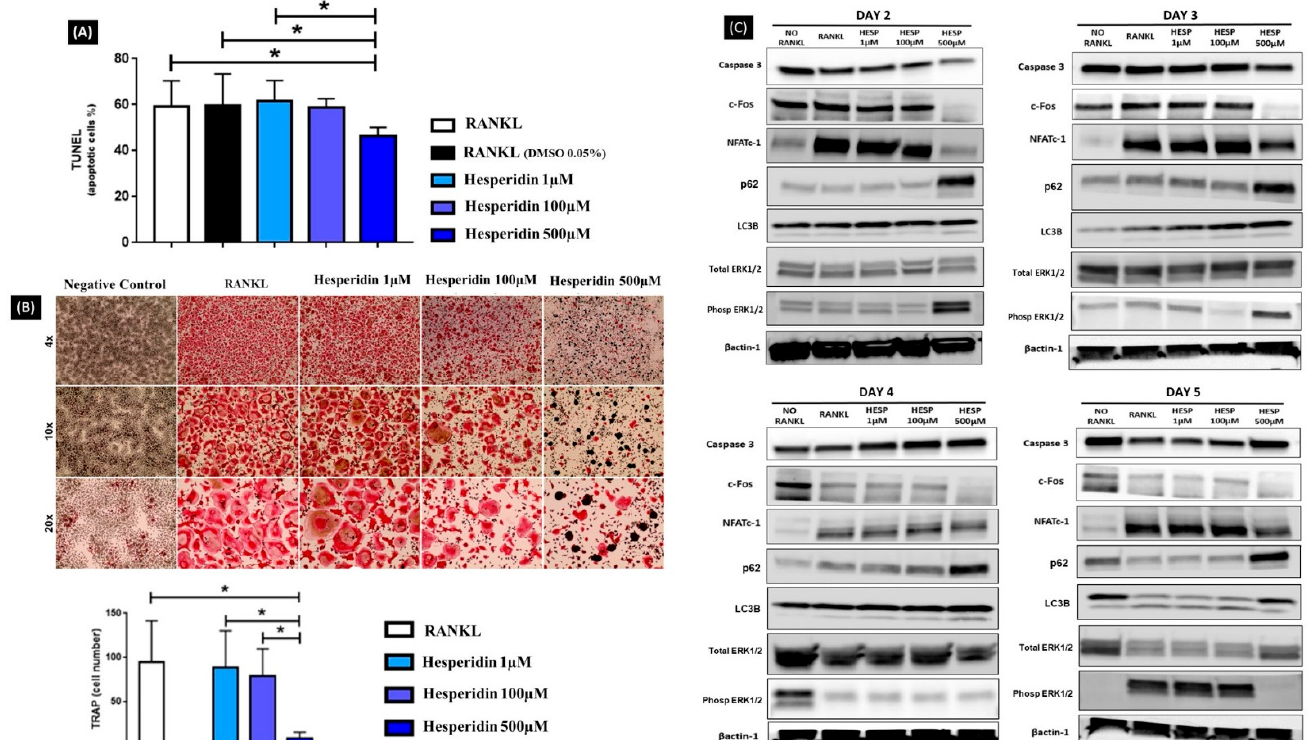
Figure 2. Overview of in vitro RANKL-induced osteoclastogenesis. RAW 264.7 cells were stimulated by RANKL with or without hesperidin treatment for 5 days. There were no differences in the percentage of apoptotic cells after 5 days of in vitro differentiation compared to RANKL control groups as measured by the TUNEL assay, except for the 500 µM HE group ( A ). ( B ) Representative images demonstrate cells differentiated in osteoclasts stained in pink by TRAP assay, 5 days post RANKL stimulation (4×, 10× and 20× magnification). Lower graph represents the average number of osteoclasts (TRAP+) quantified per group including no RANKL addition (no bar/no cells observed). Cells with 3 or more nuclei are considered osteoclasts. * p < 0.05 compared to the 500 µM hesperidin group. Hesperidin significantly affected differentiation of osteoclasts in a dose-dependent manner. ( C ) Protein expression for Caspase 3, c-Fos, NFATc1, p62, LC3B, Total ERK ½, Phosphorylated ERK ½ and Beta-Actin1 was assessed by Western blot (WB) on days 2, 3, 4 and 5 post-RANKL treatment from the sample protein lysates. Results showed influence of hesperidin on autophagy markers LC3B/LC3B-II, p62 and ERK ½ with day 5 showing most clear autophagy inhibition effect via accumulation of LC3B, marked increase in p62 and absence of ERK ½ phosphorylation (WBs were done in triplicates and representative images displayed).